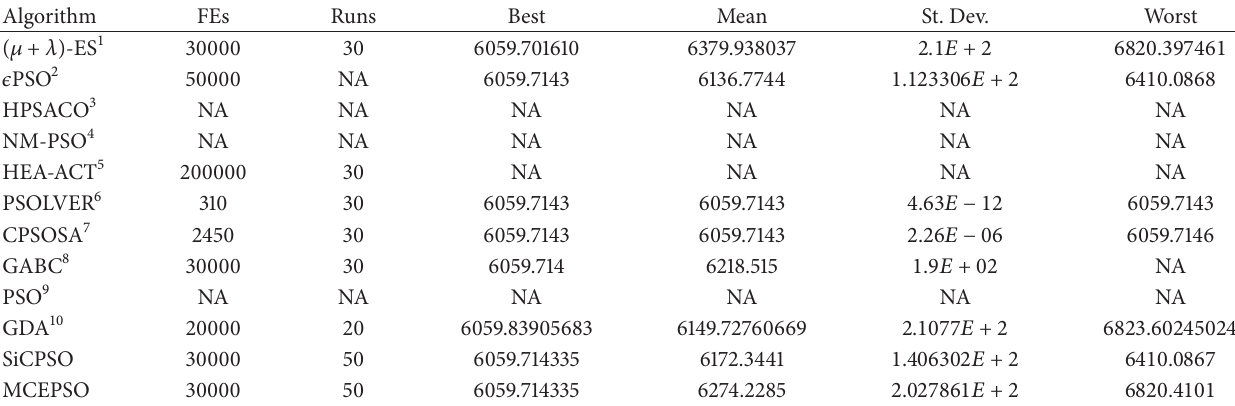
Table 4: Results for E02: pressure vessel